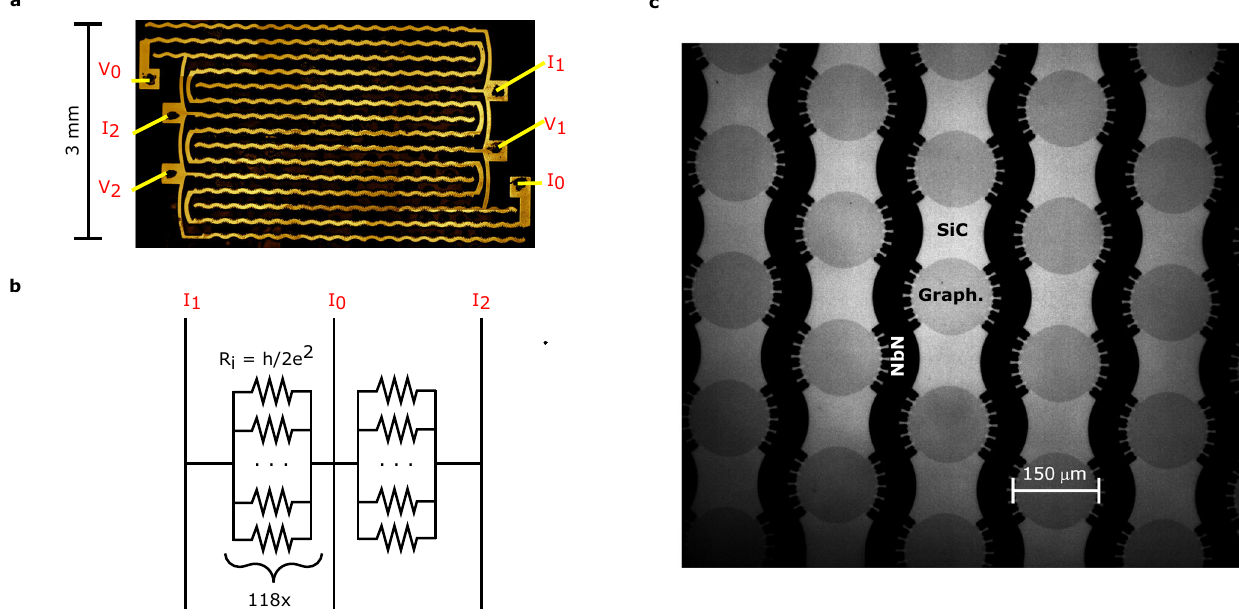
Fig. 1 | Array design. a Image is a false color composite micrograph of the whole array. It consists of two subarrays connected in series, each with 118 Hall bars in parallelforatotalof236Hallbars.Subarray1andSubarray2arebiasedandmeasured using superconducting NbN leads connected to NbN pads (named I 0,1,2 or V 0,1,2 ). Subarray 1 can be measured by sending current between pads I 1 - I 0 and measuring voltage between V